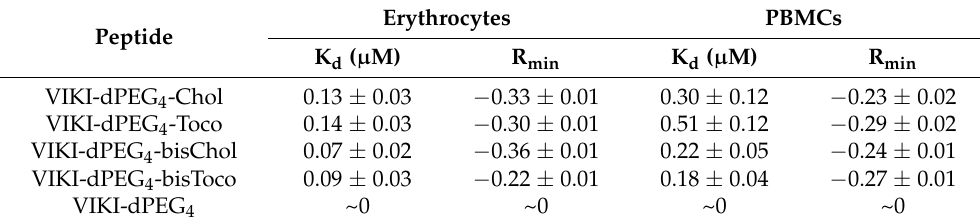
Table 3. Peptide–cell membrane interaction parameters assessed by di-8-ANEPPS fluorescence. Data are presented as the best-fit value from three independent experiments ± SE.